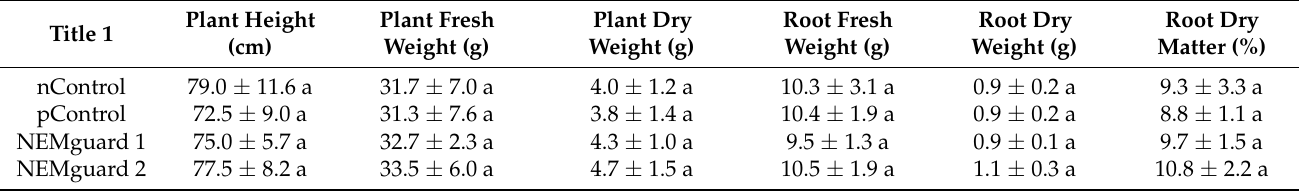
Values are means of n = 6, same letter in the same column indicate no significant differences using a one-way ANOVA (post-hoc Tukey HSD test). NEMguard 1 = NEMguard ® DE applied before planting; NEMguard 2 = NEMguard ® DE applied before planting followed by a repeated application 24 days after planting. Positive (p) control = control with M. incognita , negative (n) control = soil free of M. incognita